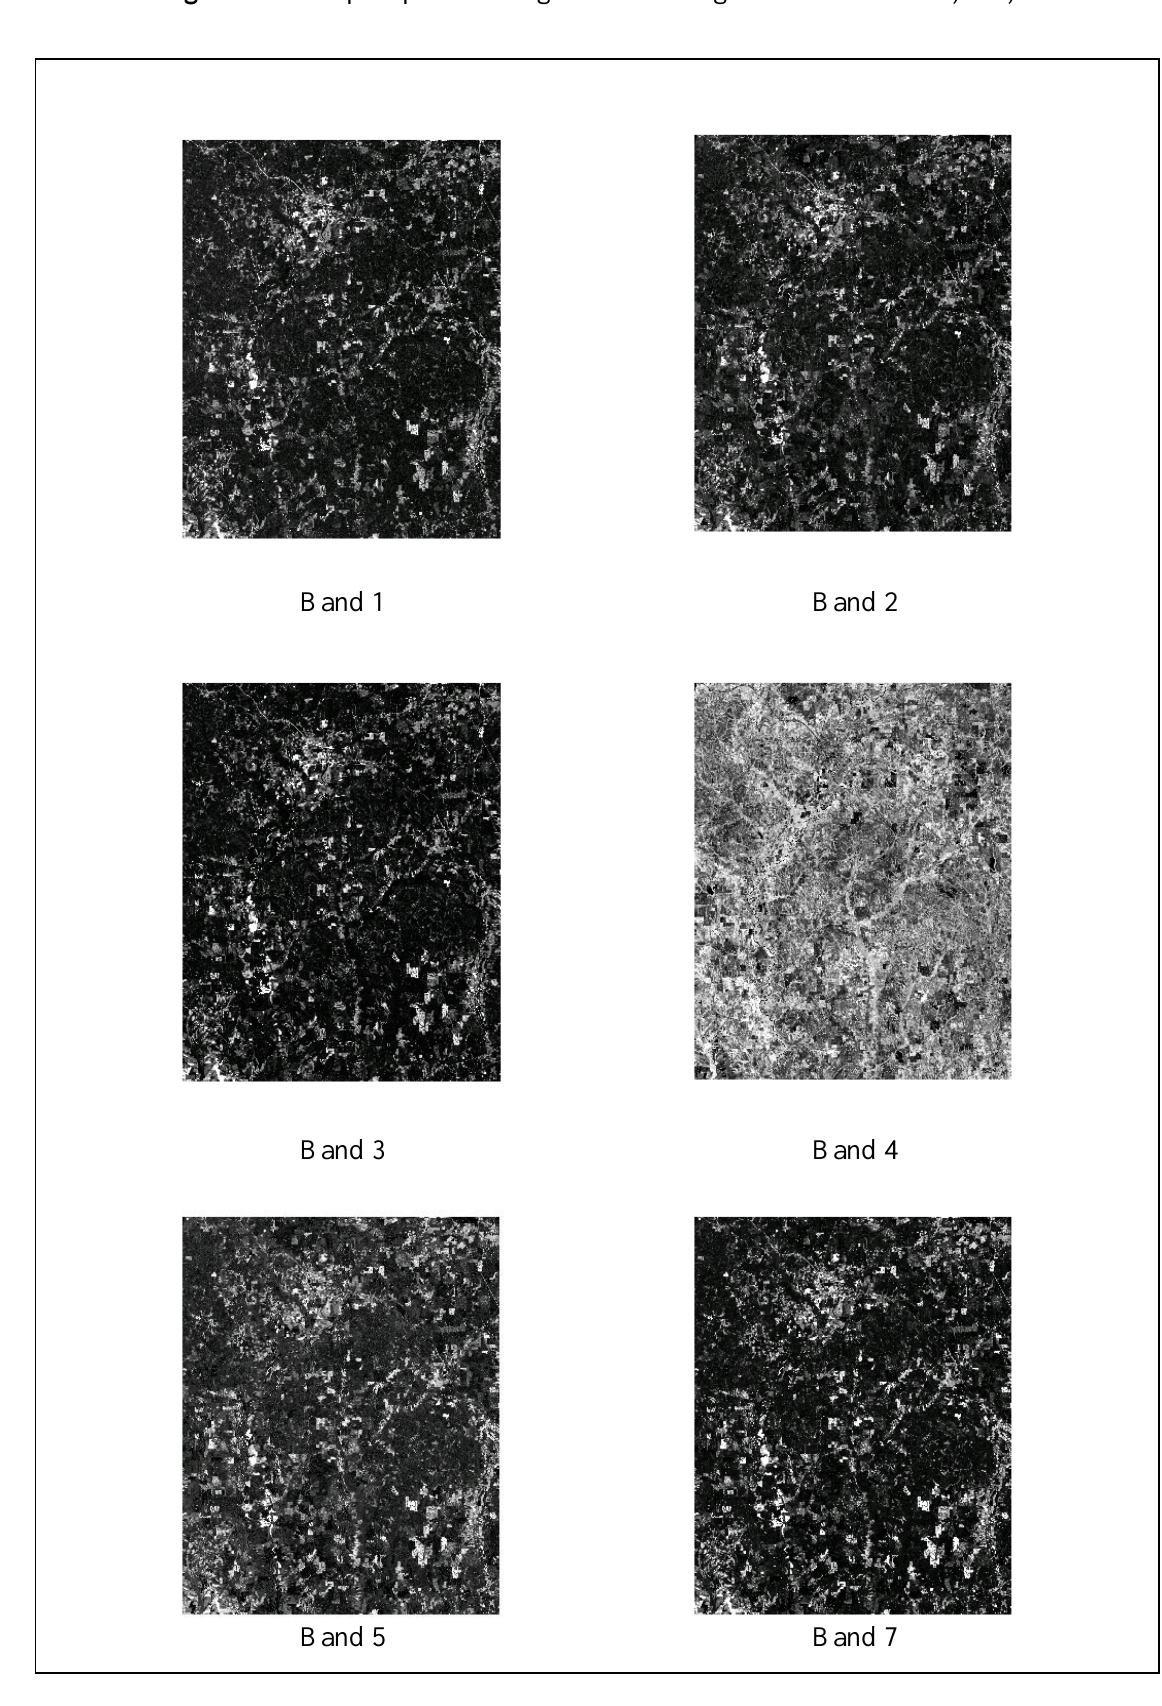
Figure 9. Multiple spectral images of Oakmulgee National Forest, AL,